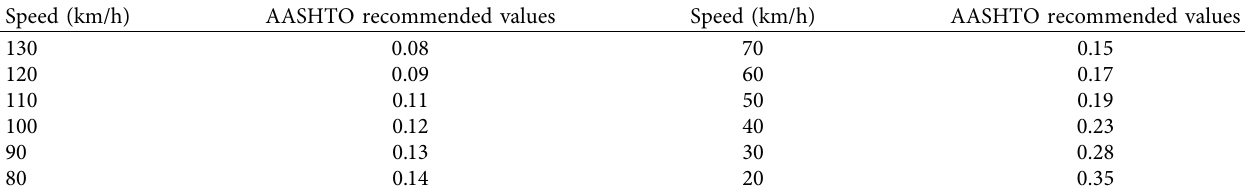
Figure 16: Comparison between the maximum side friction factor of a truck in simple and spiral horizontal curves versus the speed in the radii: (a) 1.3R, (b) 1.1R, (c) R, (d) 0.9R, and (e) 0.7R. Table 6: Maximum side friction factor amounts recommended by